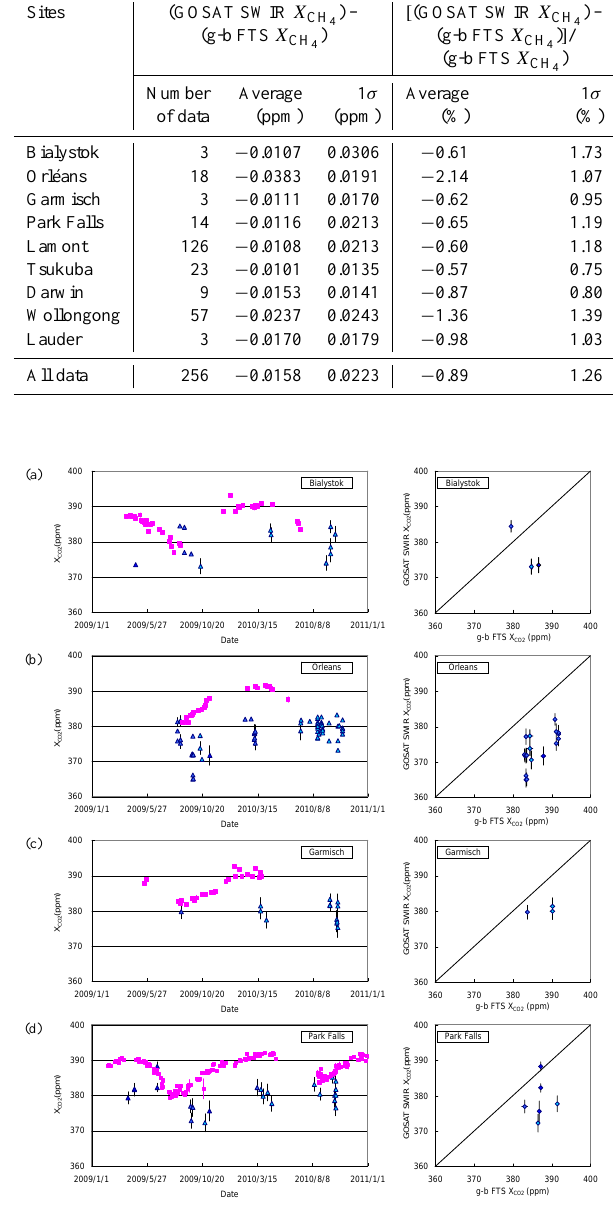
Fig. A1. Time series of GOSAT TANSO-FTS SWIR (blue trian- gles) and g-b FTS (pink squares) X CO and their scatter diagrams 2 for (a) Bialystok, (b) Orl´eans, (c) Garmisch, (d) Park Falls, (e) La- mont, (f) Tsukuba, (g) Darwin, (h) Wollongong, and (i) Lauder. The GOSAT data were retrieved within ± 2 degrees latitude/longitude box centered at each g-b FTS site and the g-b FTS data were the mean values measured within ± 1h of GOSAT overpass